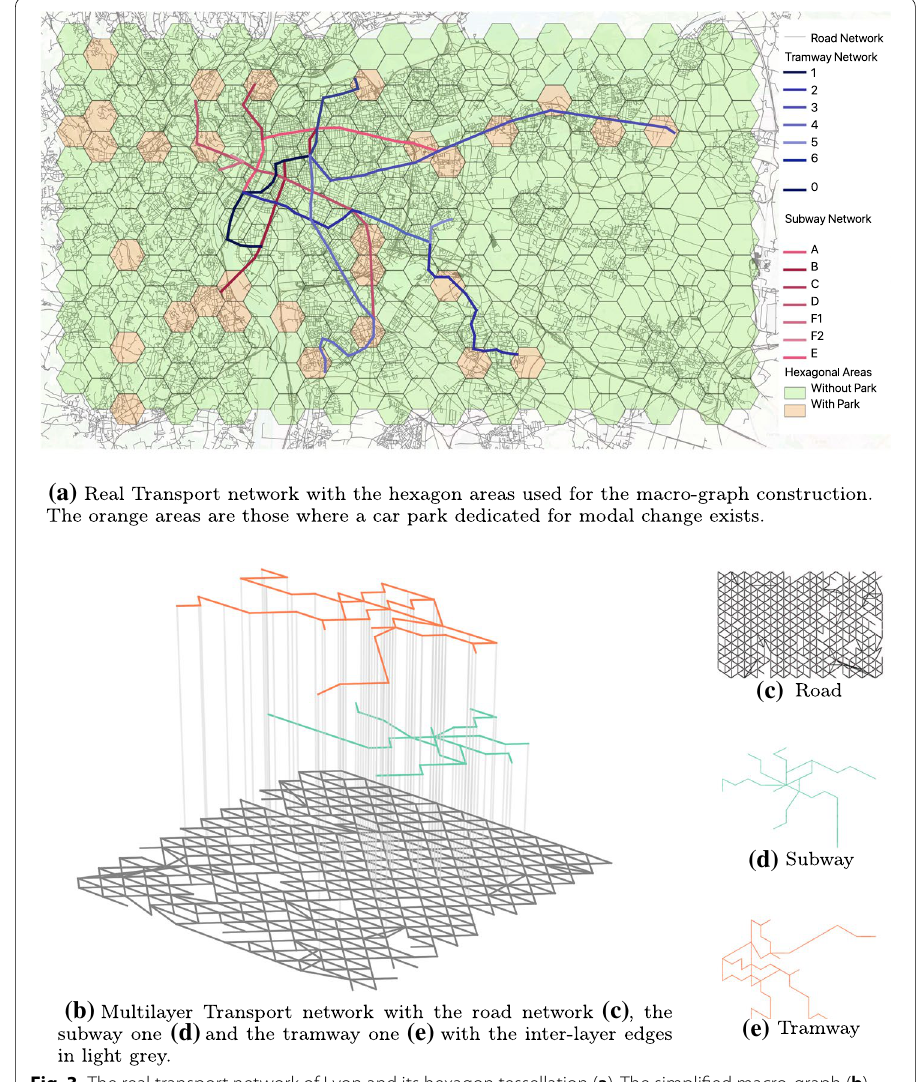
Fig. 3 The real transport network of Lyon and its hexagon tessellation ( a ). The simplified macro‑graph ( b ) when all public transport lines are constructed, with its road network ( c ), subway network ( d ) and tramway network ( e )